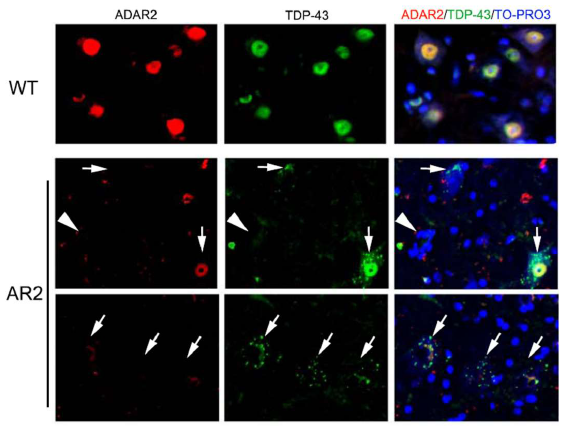
Figure 4. Transactive response DNA-binding protein (TDP-43) mislocalization and adenosine deaminase acting on RNA 2 (ADAR2) in anterior horn cells (AHCs) of spinal cord. Immunofluorescence assays revealed that ADAR2 (red) and TDP-43 (green) are both expressed in the nucleus of AHCs in wild type mice. TDP-43 immunoreactivity was absent in the AHCs of ADAR2 knockout mice (AR2; arrowhead). AHCs with low or no immunoreactivity to ADAR2 showed TDP-43 immunoreactivity in the cytoplasm and TDP-43-positive cytoplasmic aggregates in AR2 mice (arrow). TO-PRO-3 is a cellular maker (blue).